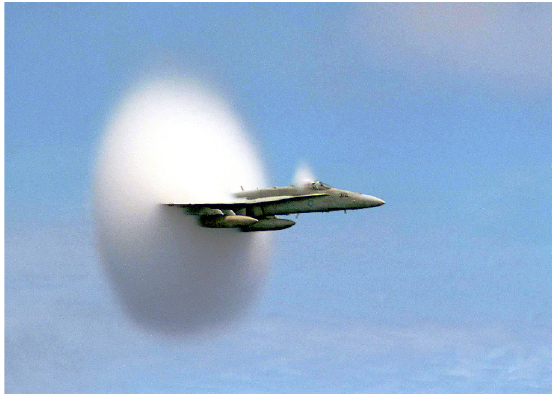
Fig. 1. F / A-18 Hornet jet fighter travelling at transonic speed in moist air (U.S. Navy photo by Ensign John Gay)